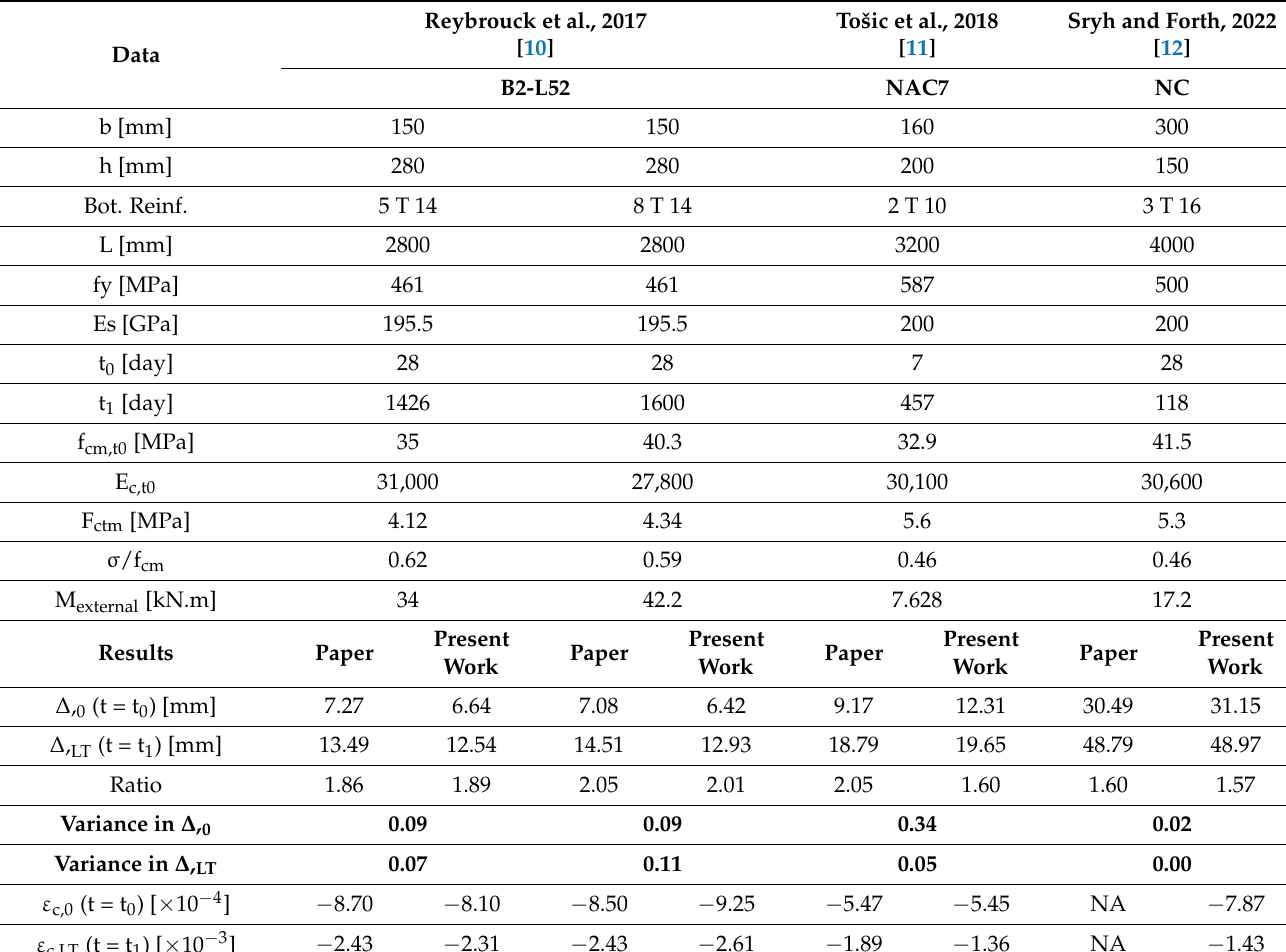
Table 1. Comparison between experiments in the literature [10–12] and the present